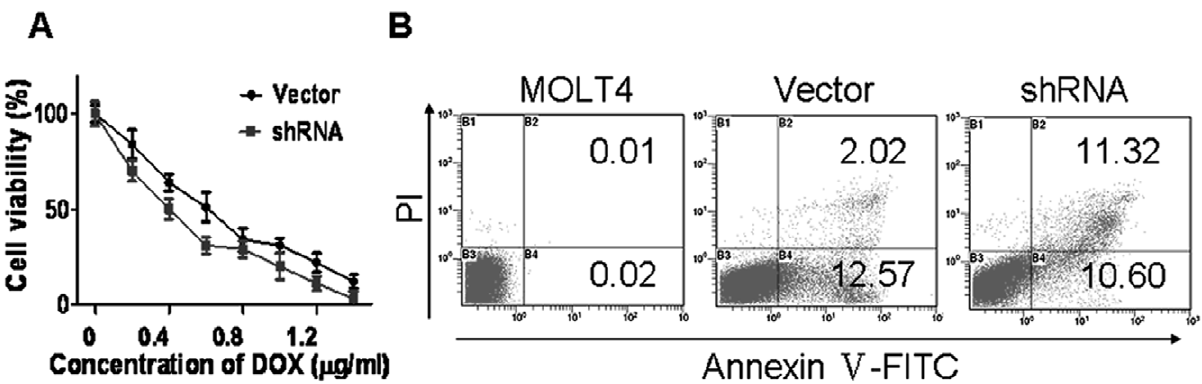
Figure 6. Cell viability and apoptosis analysis in ERM-silenced MOLT4 cells. (A) Cell viability was lower in ERM-silenced cells compared to empty vector-transfected cells. (B) The apoptosis rate in shRNA transfected cells was increased compared with empty vector-transfected cells.